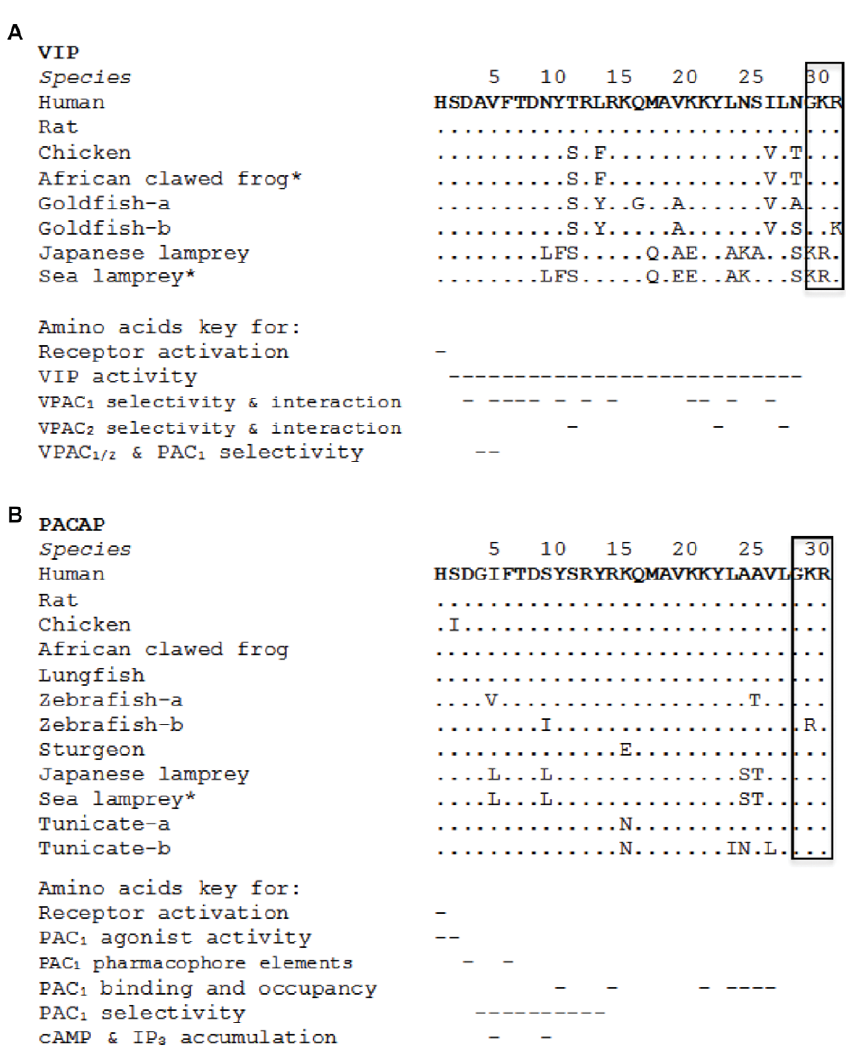
Figure 1. Amino acid alignment of VIP and PACAP-27 peptide sequences and C-terminal processing sites from various chordates. The amino acid alignment of (A) VIP and (B) PACAP-27 were generated using the default settings of Mega 5.0 software. Predicted sequences are denoted by ‘‘*’’ and retrieved from Ensembl or PreEnsembl online genome databases. The tribasic processing sites are boxed. Identical residues to that of human VIP and PACAP are denoted by ‘‘.’’. Residues indicated important for selectivity and interaction based on mammalian studies are denoted by ‘‘–’’ [28,44,46,61–72].